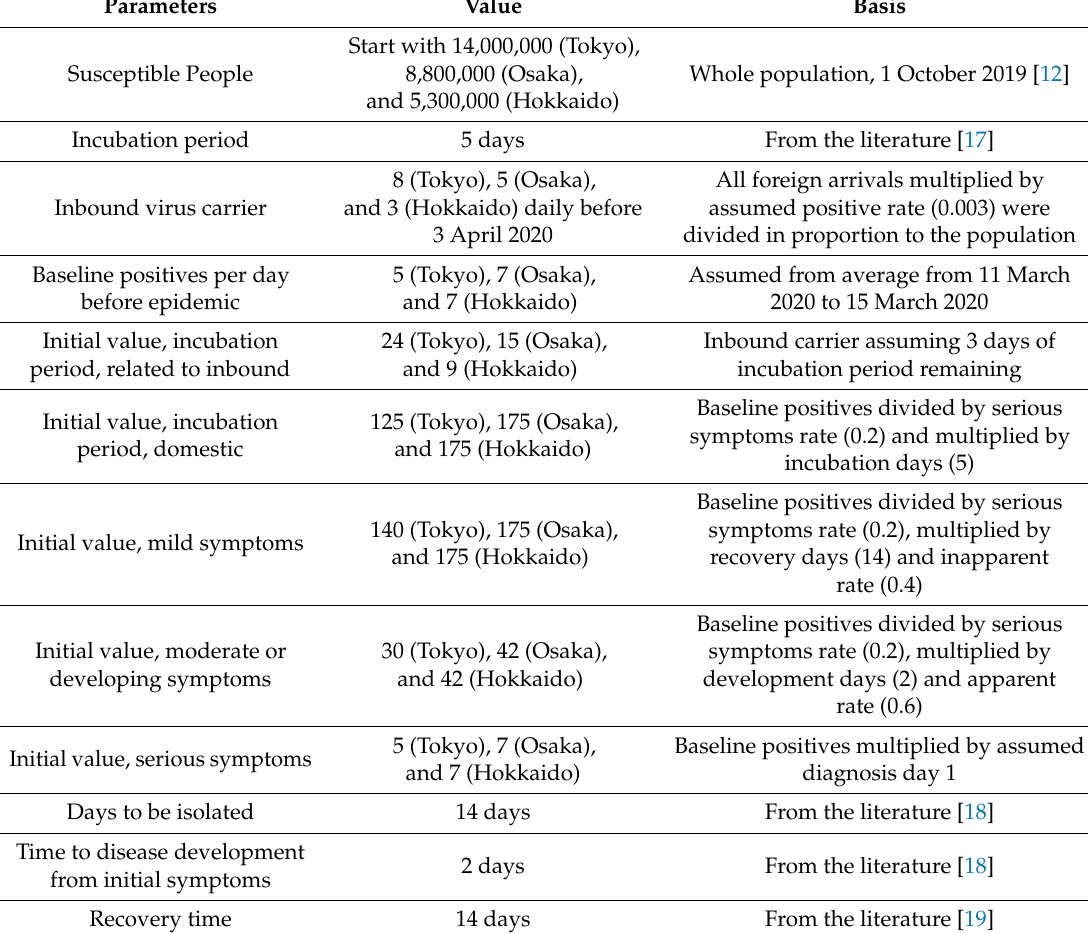
Figure 1. Stock-flow model for coronavirus disease 2019 (COVID-19) transmission. Table 1. Exogenously given parameters in 2020 spring outbreak scenario.